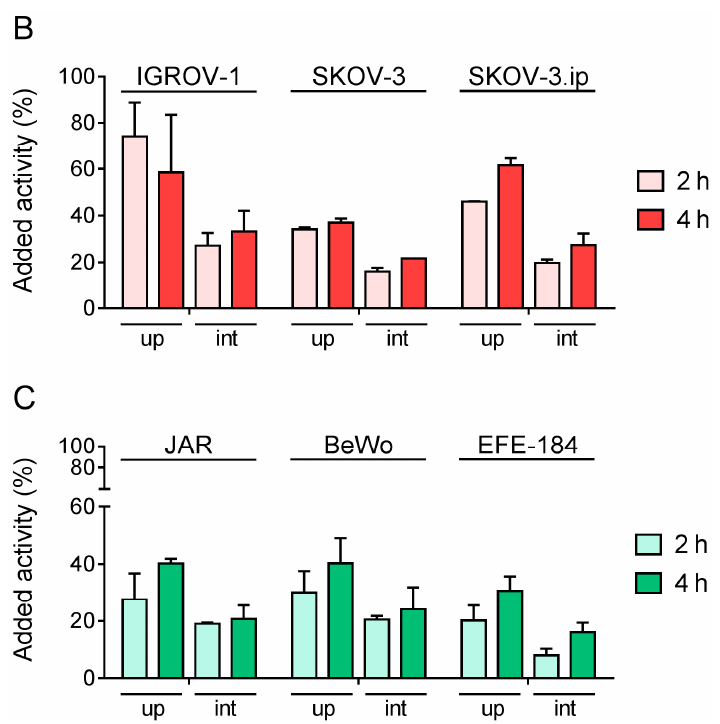
Figure 3. Total uptake (up) and internalization (int) of 177 Lu-folate in ( A ) cervical cancer cells; ( B ) ovarian cancer cells; ( C ) choriocarcinoma cells and endometrial cancer cell.